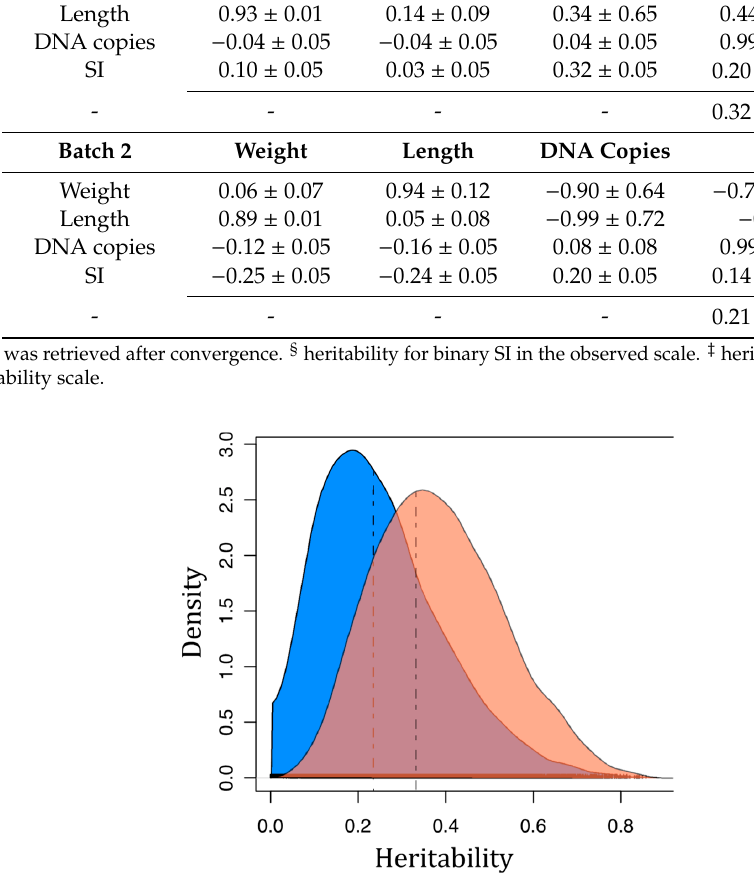
Table 1. Heritabilities (in bold) and the phenotypic (below the diagonal) and genetic correlations (above the diagonal). Means ± standard deviations (SD) are indicated for body weight, fork length, LCDV DNA copies and SI in binary scale (SI).